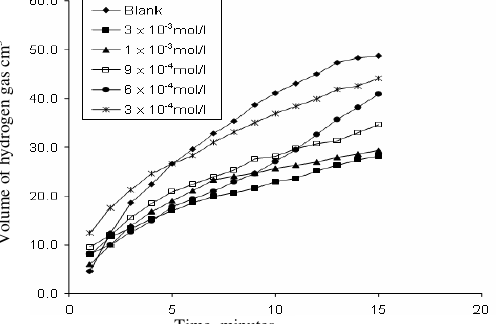
Figure 3. Variation of volume of hydrogen gas evolved with time during the inhibition